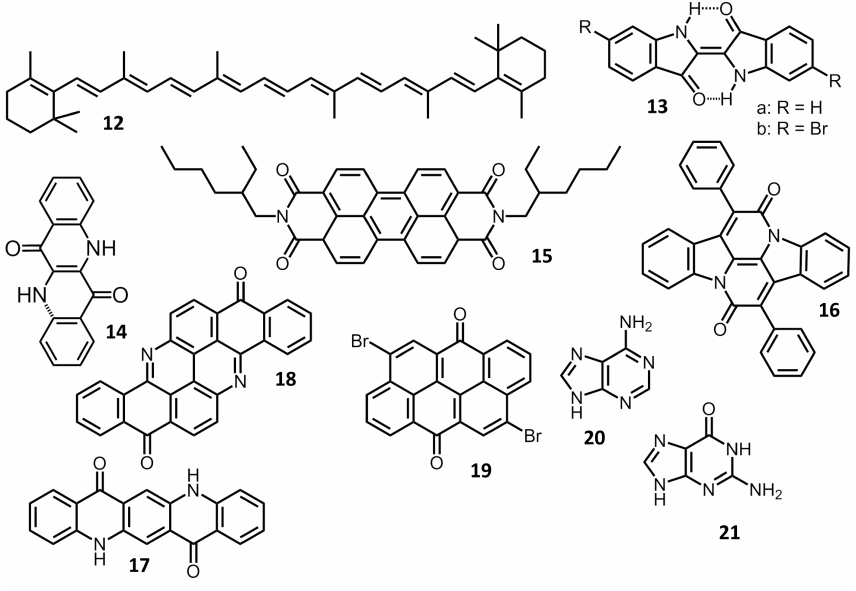
Figure 6. Chemical structures of biodegradable or biocompatible organic semiconductors ( 12 – 19 ) and dielectric materials ( 20 , 21